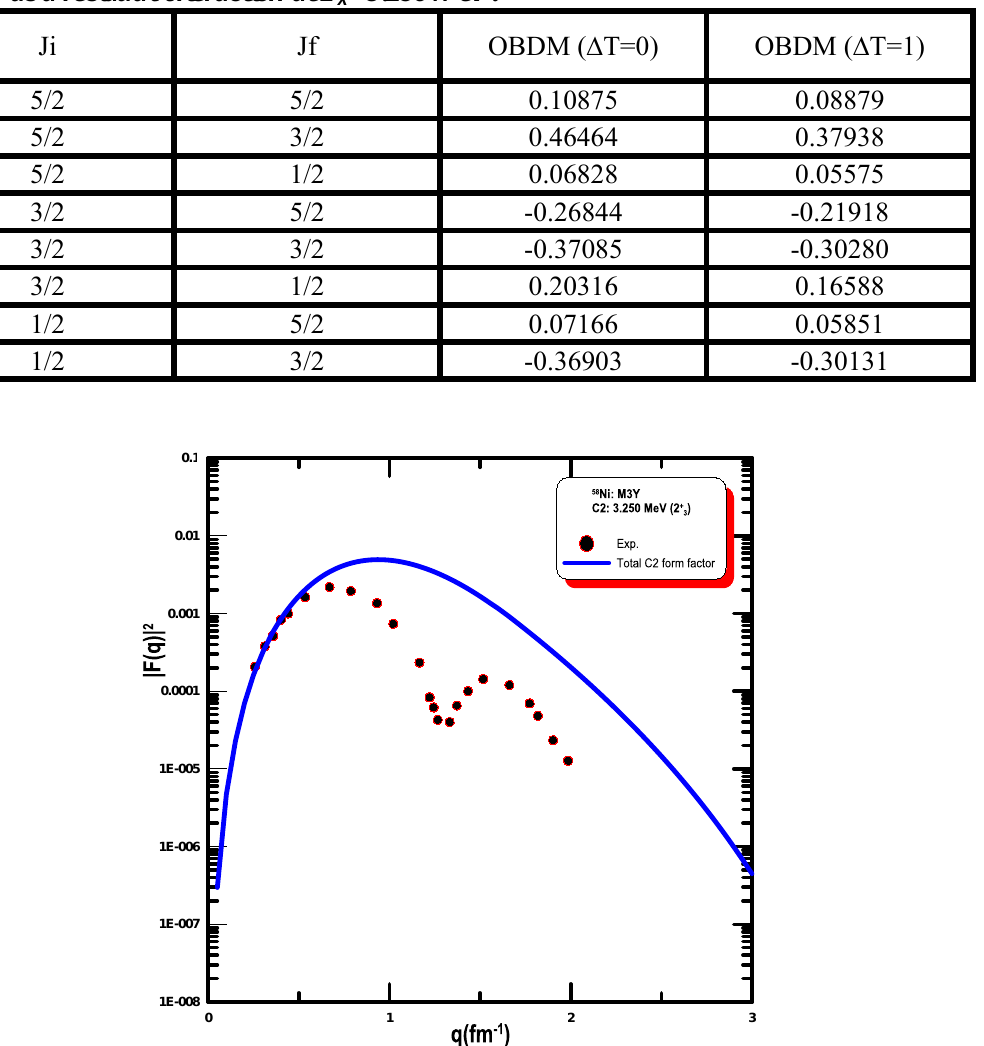
2 state at (E =3.250 MeV)in x 3